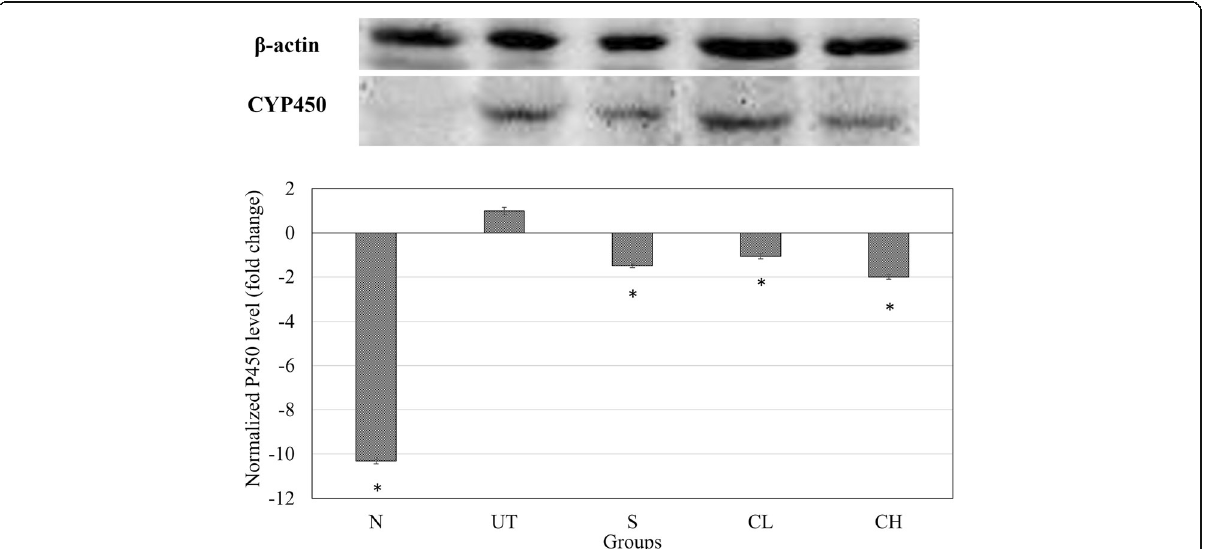
Fig. 3 Western blot analyses of CYP2E1 and β -actin proteins in the liver. All values are expressed as means mean ± SD of 6 mice in each group. * P <0.01 as compared with the untreated control group. N: normal healthy control; UT: untreated acetaminophen-induced control; S: acetaminophen- induced treated with 50 mg/kg silybin; CL: acetaminophen-induced treated with 0.08 ml/kg coconut water vinegar; CH: acetaminophen-induced treated with 2 ml/kg coconut water